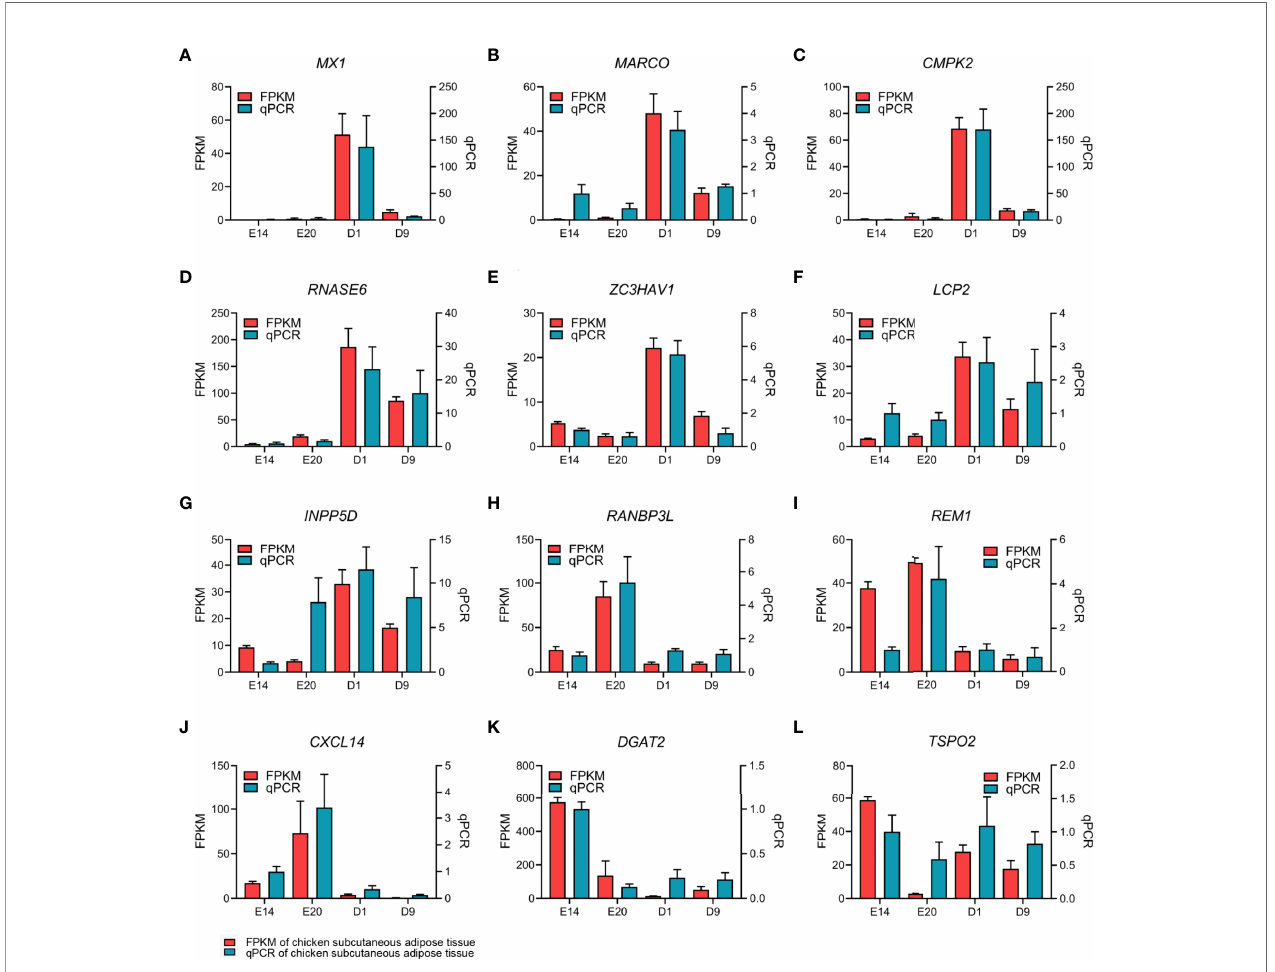
FIGURE 3 | qPCR veri fi cation of 12 EDGs between E20 and D1 in chick subcutaneous adipose tissue in four development